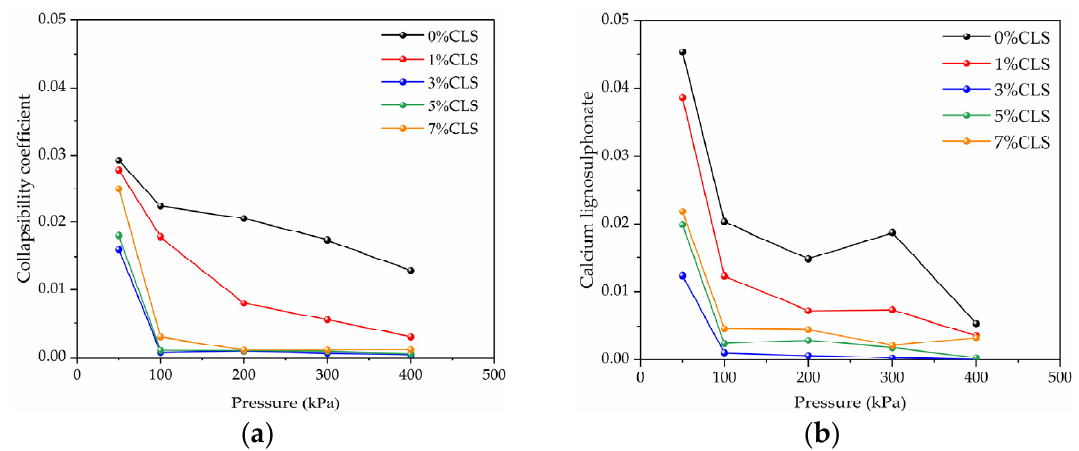
Figure 7. Collapsibility coefficient of improved loess with different compositions under various pressures. ( a )single-oedometer method; ( b ) double-oedometer method.